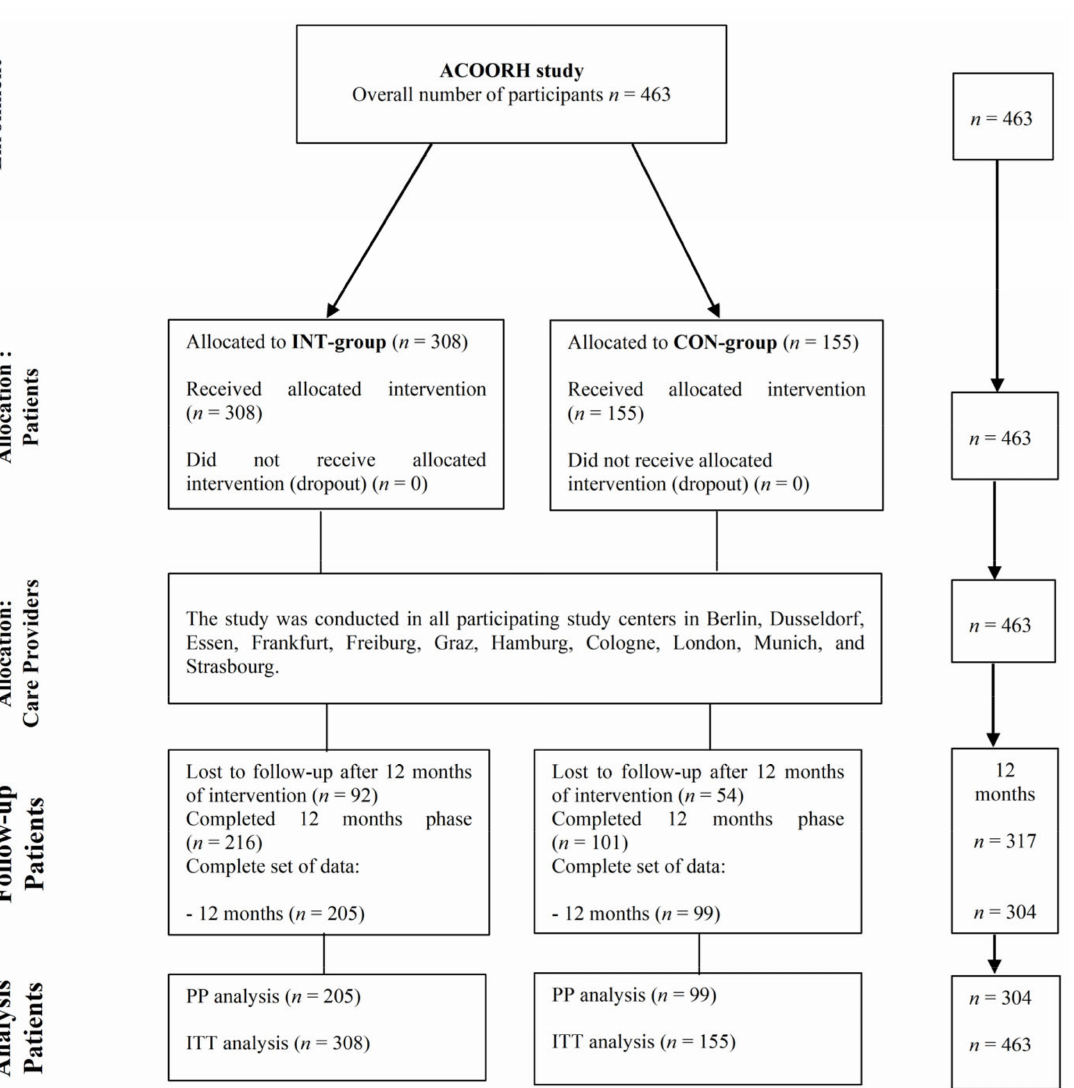
Figure 1. Flowchart. ACOORH, Almased Concept against Overweight and Obesity and Related Health Risk; CON, control group; INT, intervention group; ITT, intention-to-treat analysis; PP, per protocol